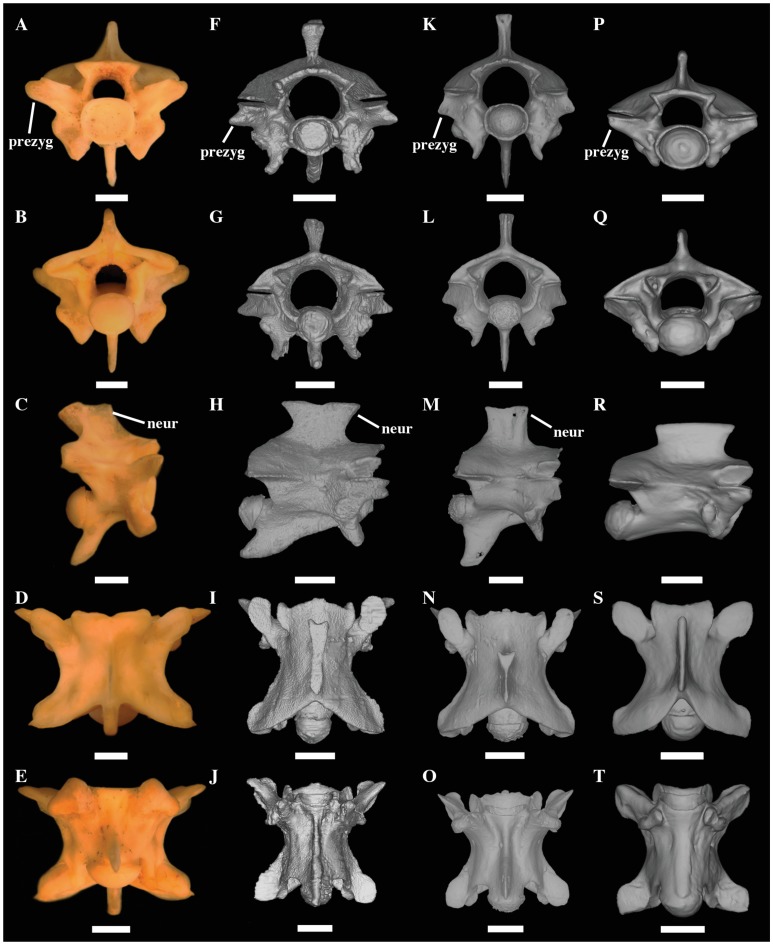
Mid- to posterior trunk vertebrae of Acrochordus
javanicus (A-E), Achalinus rufescens
(F-J), Fimbrios klossi (K-O), and
Pareas sp. (P-T).Photographs (A-E) and three-dimensional surface views based on high
resolution X-ray computed tomography. A, F, K, P, anterior views; B,
G, L, Q, posterior views; C, H, M, R, right lateral views; D, I, N,
S, dorsal views; E, J, O, T, ventral views. Legends: prezyg.,
prezygapophysial process; neur., neural spine. Scale bar = 2 mm
(A-E) and 1 mm (F-T).